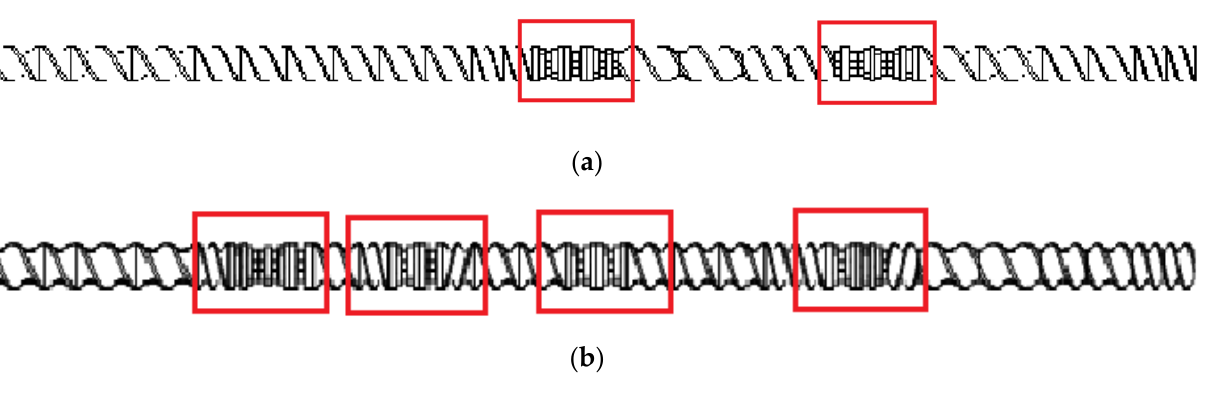
Figure 1. Scheme of the plasticizing system: ( a ) configuration 1 (two kneading and mixing zones); ( b ) configuration 2 (four kneading and mixing zones). The kneading and mixing zones are marked. Three different temperatures of the plasticizing system were used: 210 °C, 230 °C or 250 °C (Table 1). Table 1. Summary of parameters of extrusion processes. Abbreviations: configuration 1—screw with two kneading and mixing zones; configuration 2—screw with four kneading and mixing zones.